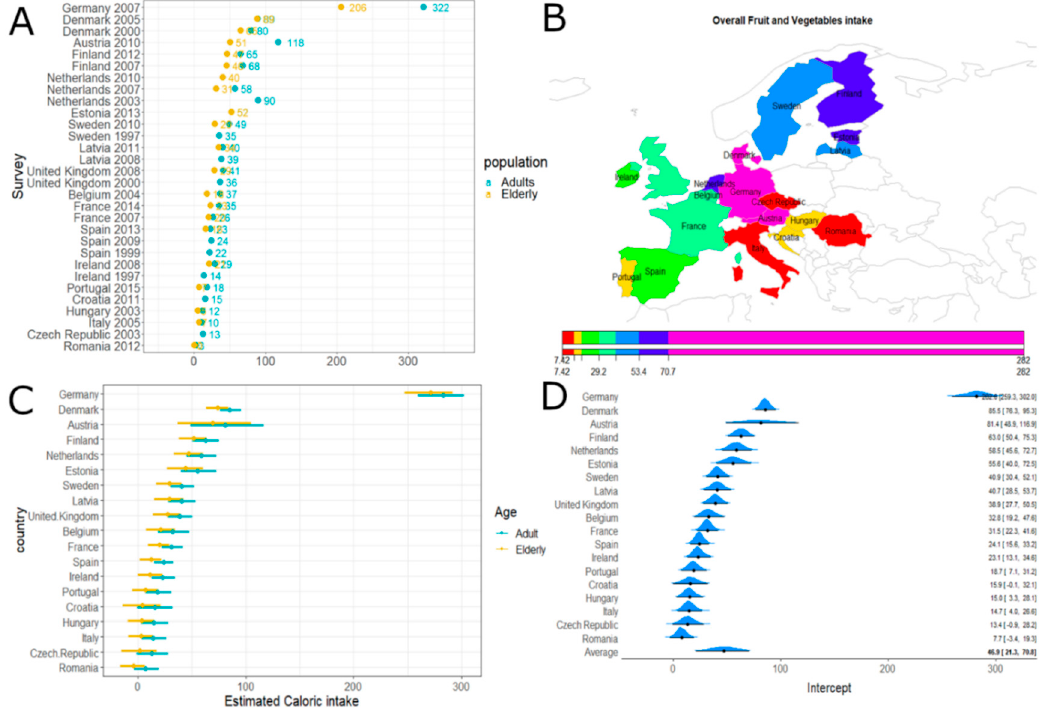
Figure 5. Fruit and vegetable juice and nectar caloric intake. Panel ( A ): Fruit and vegetable juice and nectar (including concentrates) caloric intake (obtained by summing the means over the L7 levels) according to surveys and age classes. Panel ( B ): Estimated caloric intake across European countries. Panel ( C ): Estimated caloric intake across European countries according to age classes with 95% credibility intervals. Average e ff ect estimate (95% CI) 46.86 [21.27; 70.81] and age e ff ect (95% CI) –11.62 [–5.56; –18.78]. Panel ( D ): Estimated caloric intake across European countries (without age e ff ect) with 95% credibility intervals.